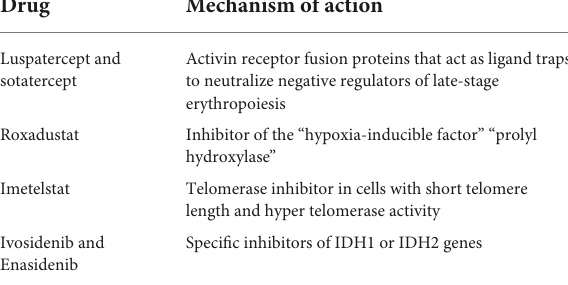
TABLE 3 Treatment goals in low- and high-risk myelodysplastic syndromes (MDS) patients (20). Order of priority